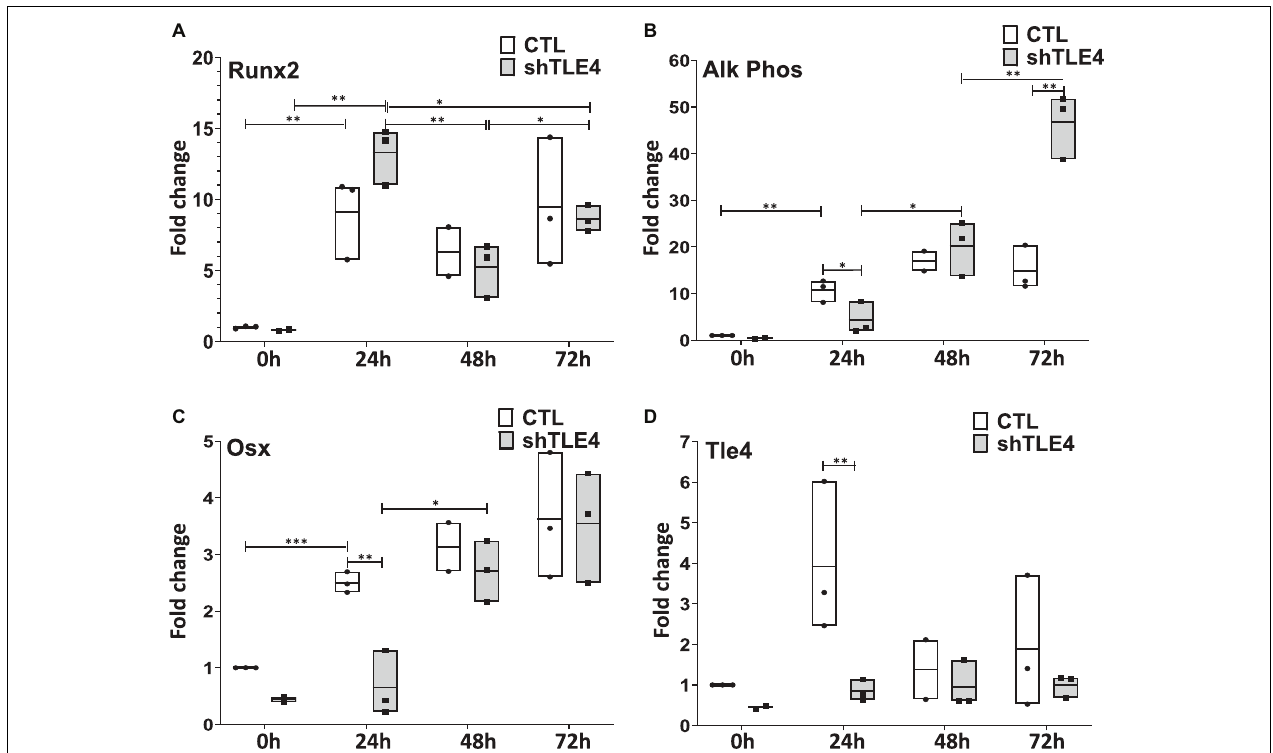
FIGURE 6 | Time-course gene expression study demonstrates altered expression of Runx2 and its bone-related targets due to Tle4 knockdown (shTLE4) compared with control cells (CTL) in ST2D cells at 0, 24, 48, and 72 h. (A) ST2D cells that contain a doxycycline inducible Runx2 gene demonstrated maximal Runx2 induction after 24 h. (B) This is associated with an upregulation of alkaline phosphatase that was slightly delayed with Tle4 knockdown. (C) Tle4 knockdown also slows the induction of the osteoblast-specific transcription factor Osterix (Osx). (D) The knockdown of Tle4 achieved with a Tle4 specific shRNA was demonstrated at the different time points in this experiment. (0—knockdown to 37%, 24 h to 22%, 48 h to 69%, 72 h to 53%) ( n = 3 biologic replicates per arm, technical triplicates; * p < 0.05, ** p < 0.01, *** p < 0.001, and Student t -test).